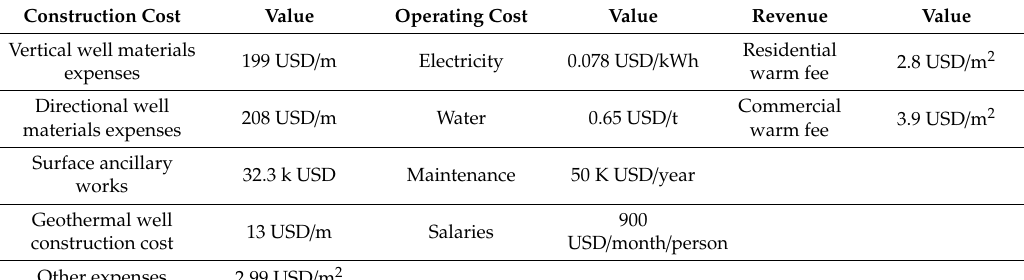
Table 3. Economic calculation parameters for the base case.